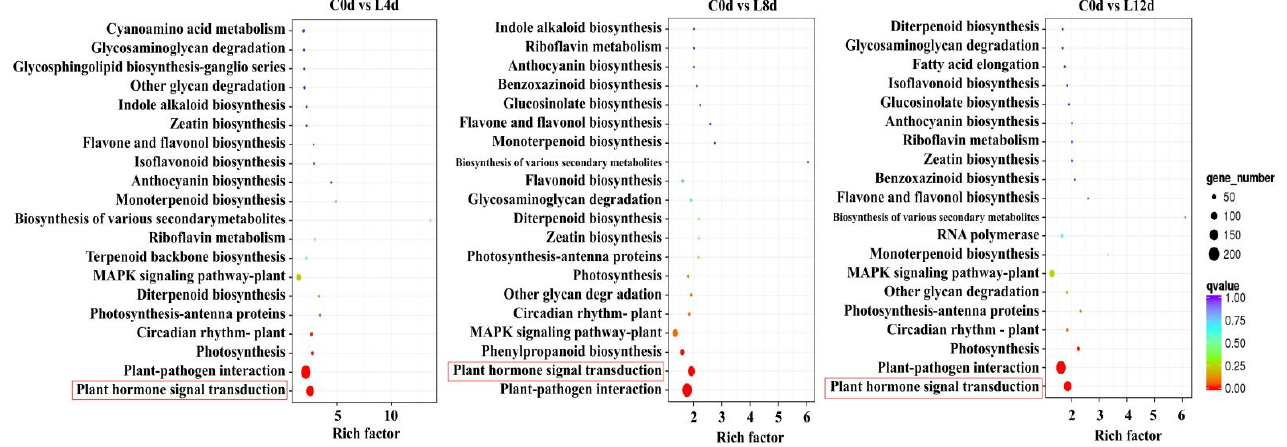
Figure 5. KEGG enrichment analysis of the DEGs. ‘Huaizhi’ litchi trees were grown in a chamber with 22 °C/17 °C (day/night temperature, 12 h day and 12 h night) as the normal temperature. Temperatures dropped from the normal one to 2 °C for 4 d, and then were maintained at 2 °C for another 8 d. C0d, L4d, L8d, and L12d mean the leaves samples at 0 d, 4 d, 8 d, and 12 d of chilling stress.